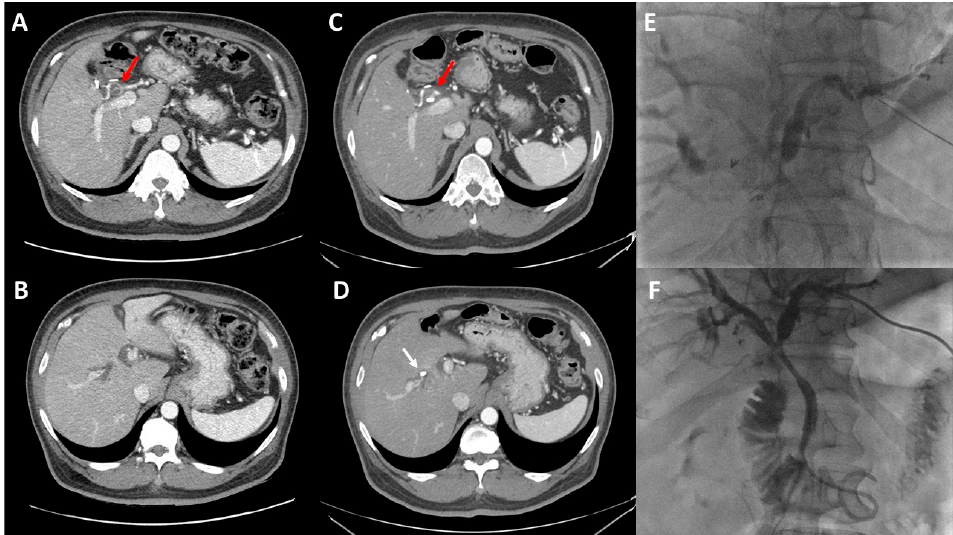
Figure 2. Repeat drainage following misplaced endoscopic biliary drain. Computed tomography showing perihilar tumor with involvement of right hepatic artery (( A ), red arrow ) with dilation of both left and right intrahepatic biliary trees ( B ). Repeat scan after placement of endoscopic biliary stent shows persistent arterial involvement (( C ), red arrow ) with inappropriate placement of the endoscopic stent into the right liver (( D ), white arrow ). The left liver (future liver remnant) remains undrained. Patient subsequently underwent selective percutaneous access of the left biliary tree ( E ) with placement of an internal-external biliary drain ( F